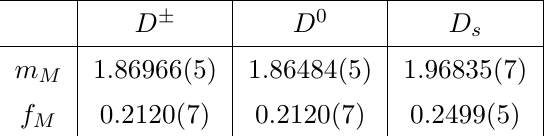
Table 15. Values of input parameters used in the numerical analysis. Uncertainties in the final digit(s), which are neglected in this study, are given in brackets. The value of m by the Flavour Lattice Averaging Group (FLAG) [104, 105] of the lattice QCD results in [93–97]. The value of m ( m ) is the FLAG average of the lattice QCD results in [154–156]. b b